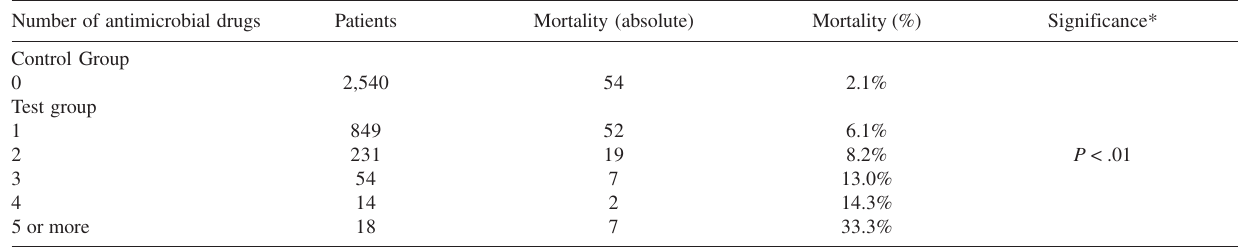
Table 3 - Hospital mortality according to number of anti-infective agents (All patients, n = 3,706) Number of antimicrobial drugs